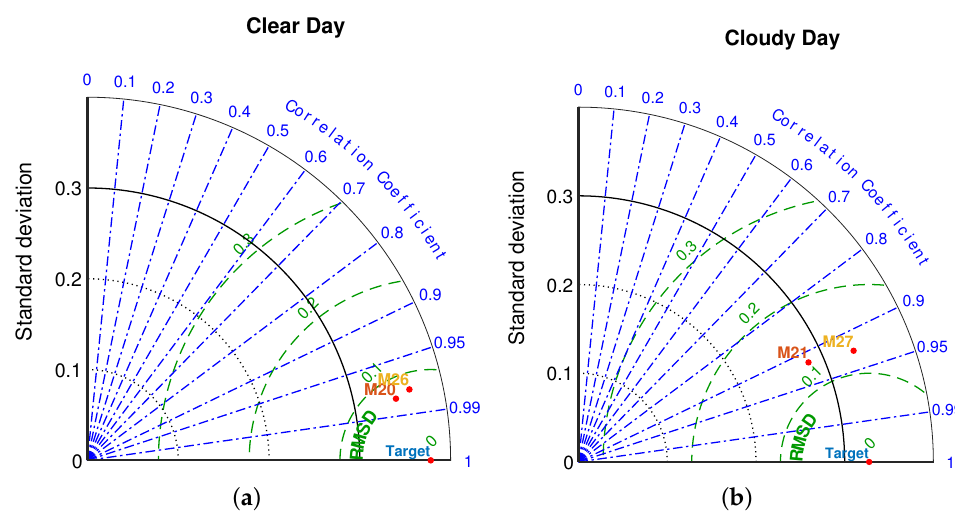
Figure 12. Comparison of clear and cloudy days for satellite data when time steps = 15: ( a ) Clear sky. ( b ) Cloudy